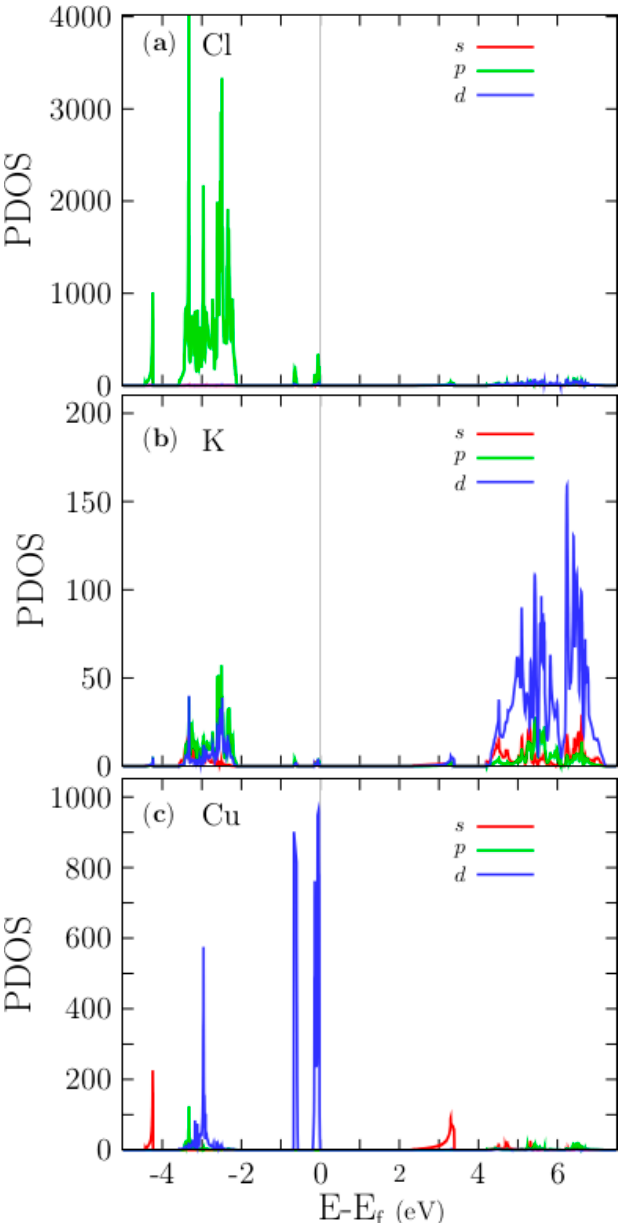
Figure 4. The upper panel ( a ): Kohn–Sham PDOS for the Cl atom. Middle panel ( b ): Kohn–Sham PDOS for the K atom. The lower panel ( c ): PDOS for the Cu atom. The Cu-3d states dominate at the Fermi level with a sharply peaked density, and at 2.2 eV, the Cu-4s states dominate. For all atoms, s-, p-, and d-states are identified by red, green and blue lines, respectively.